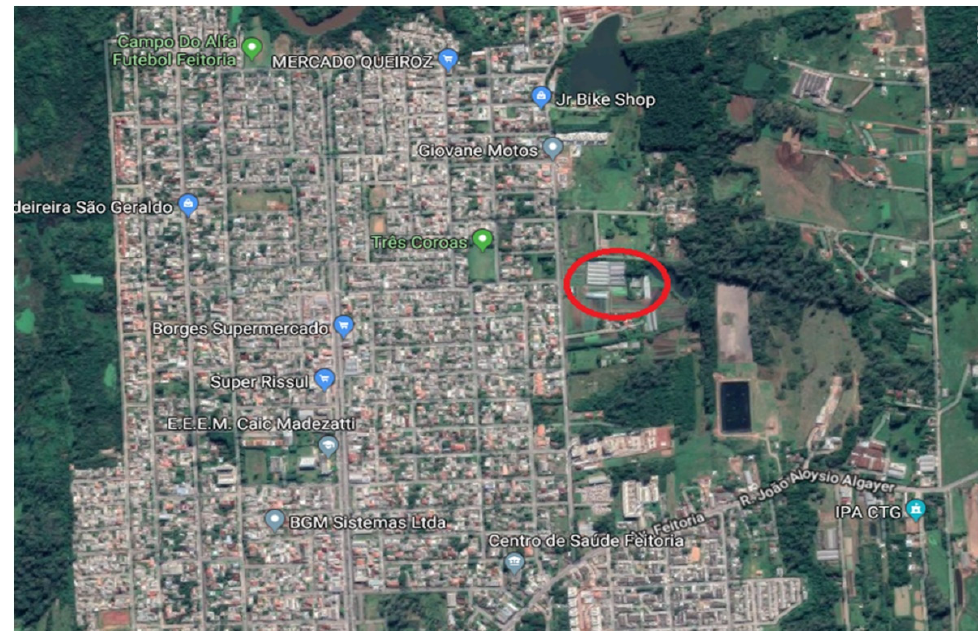
Figure 3. Location of farm that tested IndoorPlant.